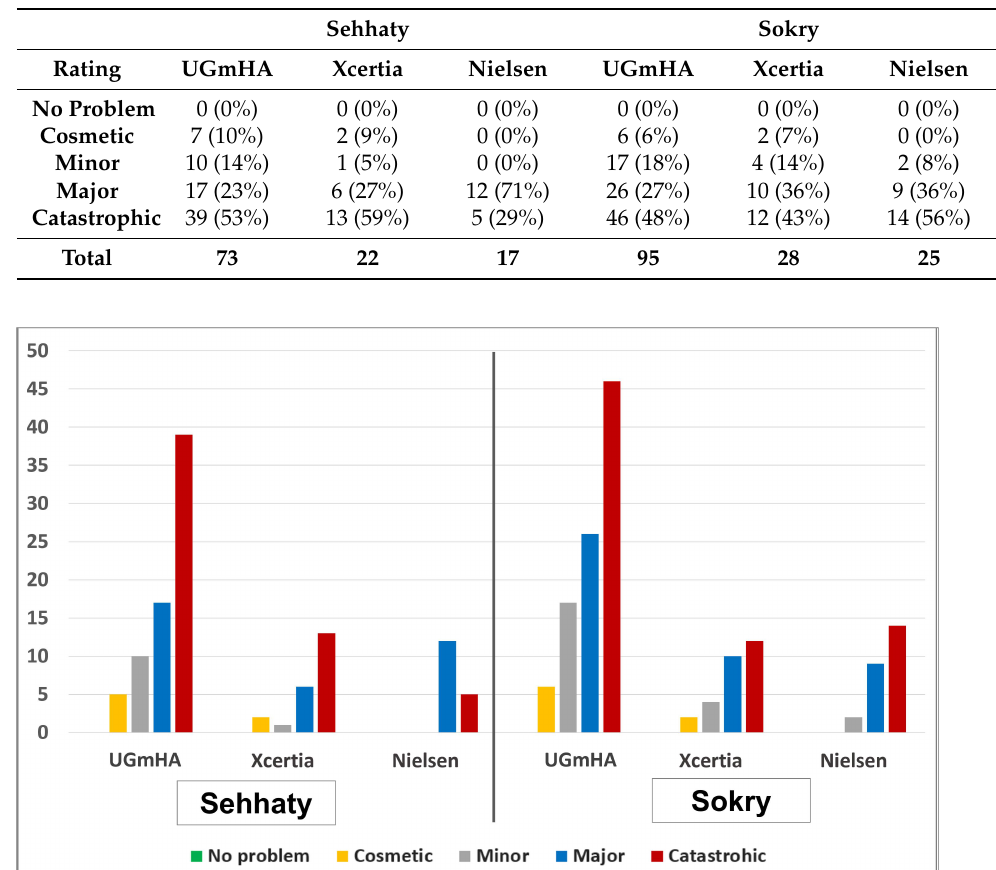
Figure 5. Severity of issues in the “Sehhaty” and “Sokry” applications among the three guidelines. However, the least unapplied guidelines in “Sehhaty” were error diagnosis and recovery with one issue, while the least unapplied guideline in “Sokry” was match between system and real world with one issue.